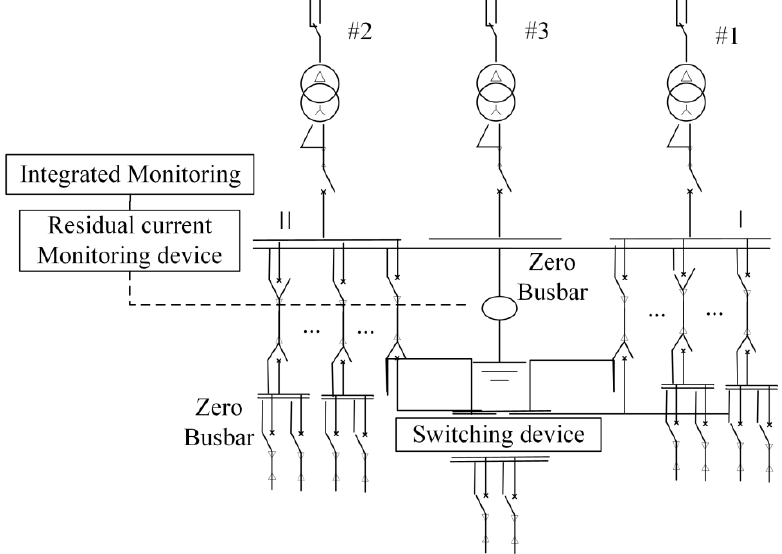
Figure 2. Long cable residual current acquisition.